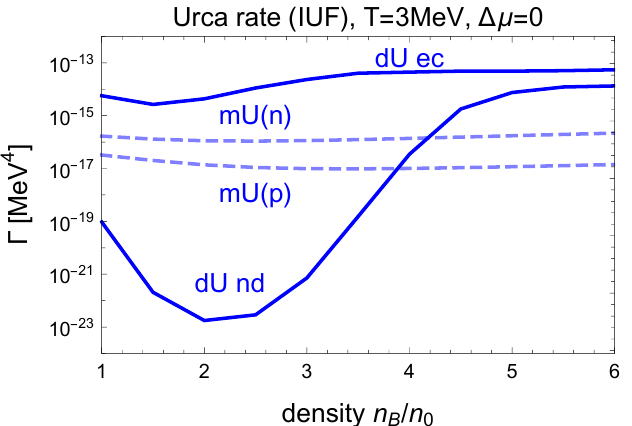
Figure 9. Urca rates calculated using the IUF EoS at T = 3MeV. Because ∆ µ = 0 there is a large mismatch between the direct Urca rates for neutron decay and electron capture. Modified Urca (with neutron spectator (n) and proton spectator (p)) rates are calculated in the Fermi surface approximation and therefore match automatically.